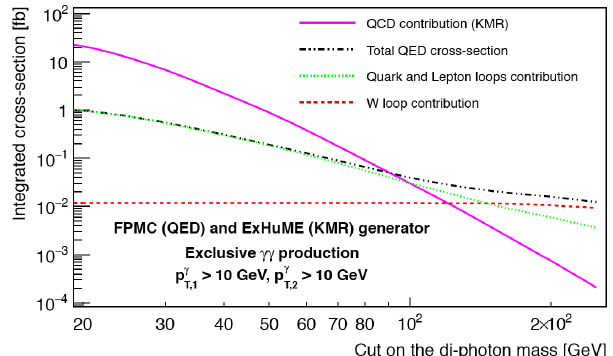
Figure 3: Cross section of exclusive diphoton production above a given diphoton mass given in abscissa for QCD (full line) and QED (dashed dotted line)